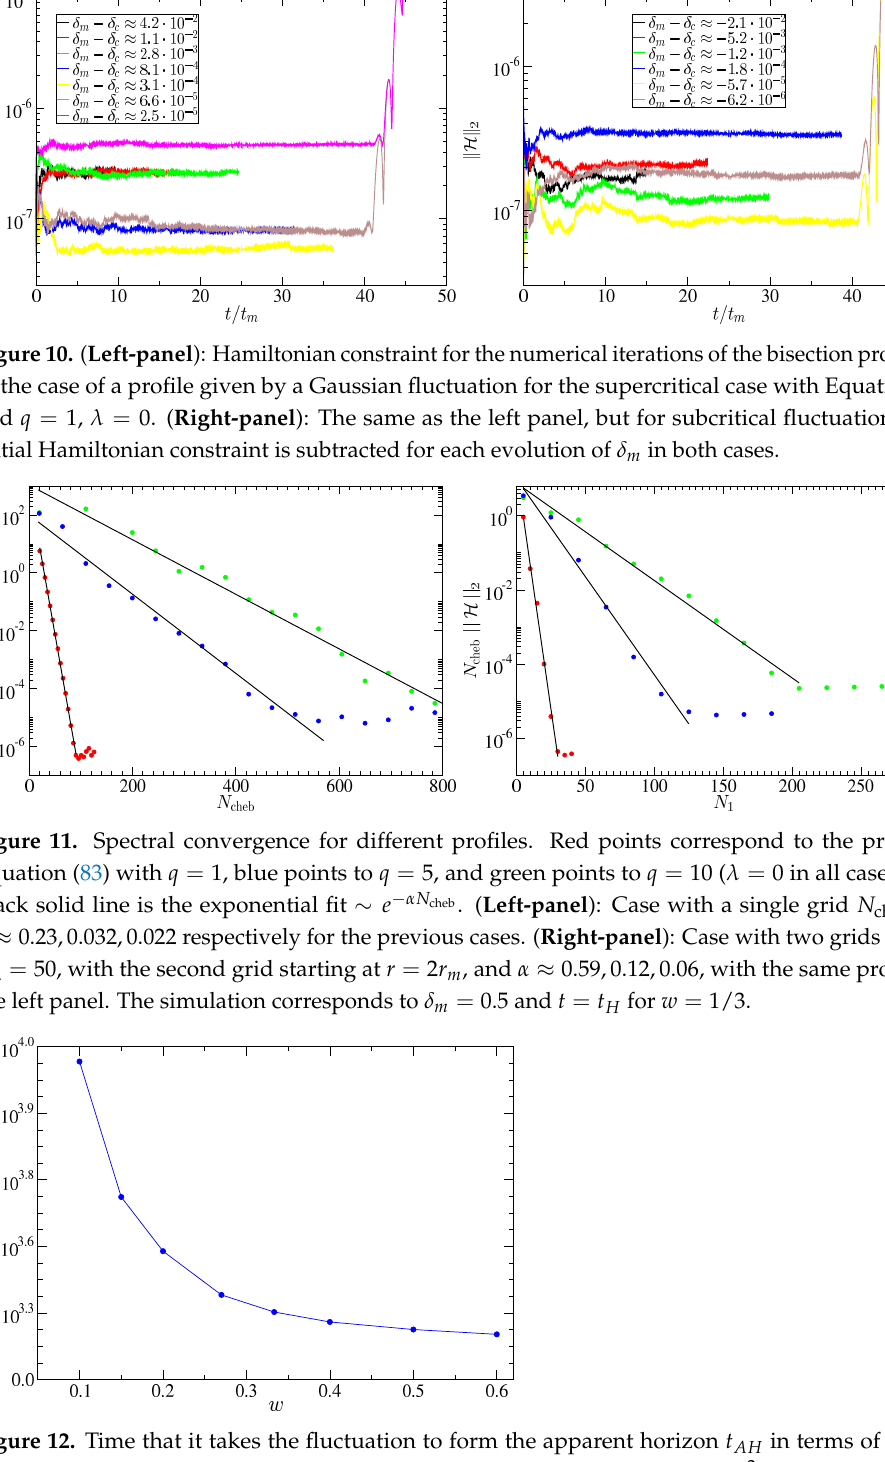
Figure 12. Time that it takes the fluctuation to form the apparent horizon t AH in terms of w . The fluctuation chosen corresponds to Equation (82) with q = 1 and δ m = δ c + 10 − 2